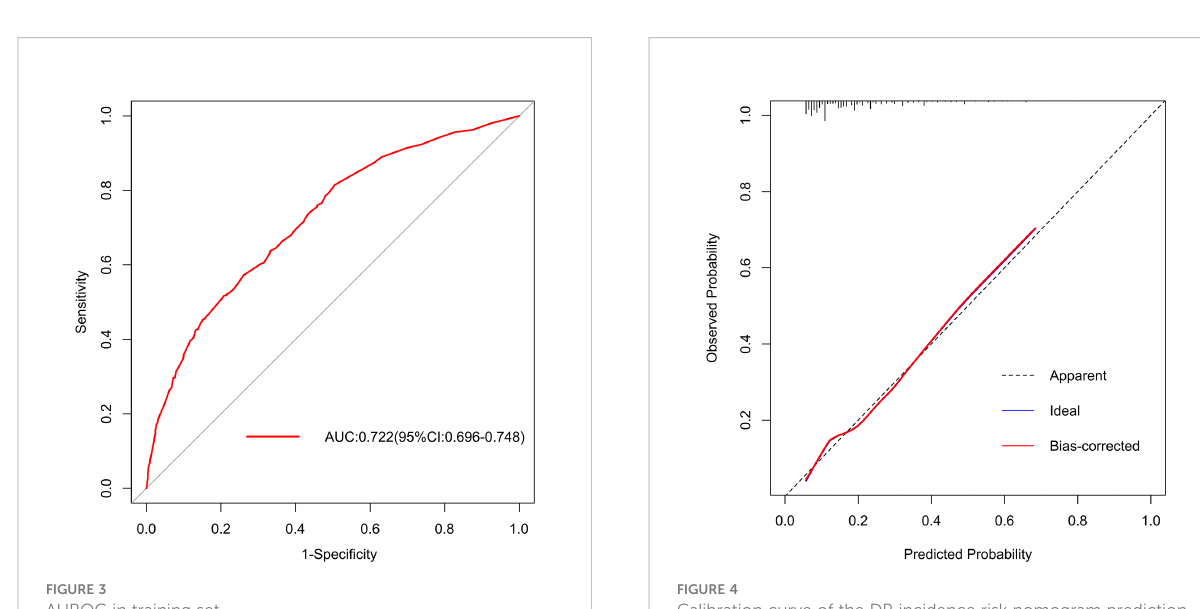
FIGURE 4 Calibration curve of the DR incidence risk nomogram prediction in training set.